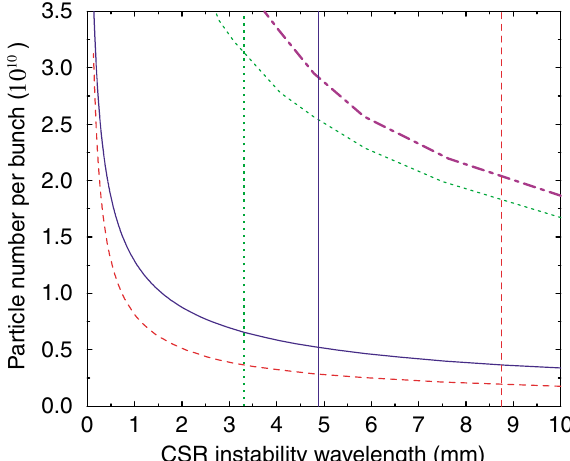
FIG. 5. (Color) The threshold particle number as a function of the CSR wavelength for the NLC main damping ring. The (cid:4) 0 with the vertical dashed straight dashed curve is for F w line indicating the corresponding cutoff wavelength. Their cross point gives the threshold at the cutoff wavelength. The solid curve and vertical solid straight line are for the case of (cid:4) 2 : 2 , the nominal case in Table I. The dotted curve and F w (cid:4) 6 : 5 . The vertical dotted straight line are for the case of F w (cid:4) 6 : 5 , but the imped- dot-dashed curve is for the case of F w ance is the dipole CSR impedance